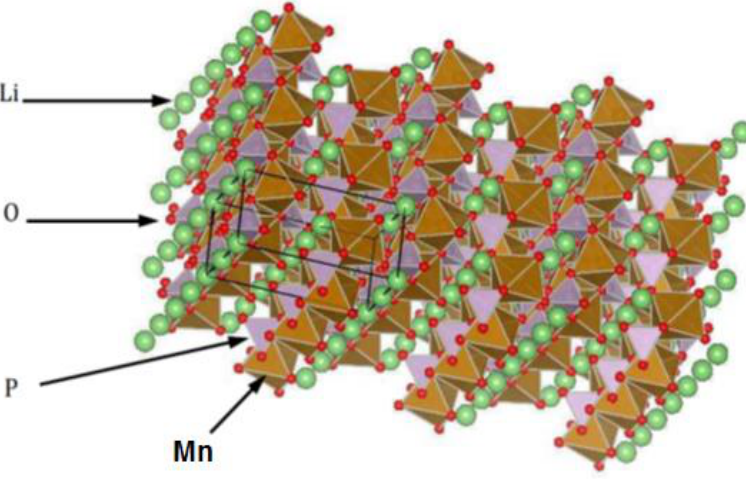
Figure 5. Structure of the LiMnPO 4 [60].